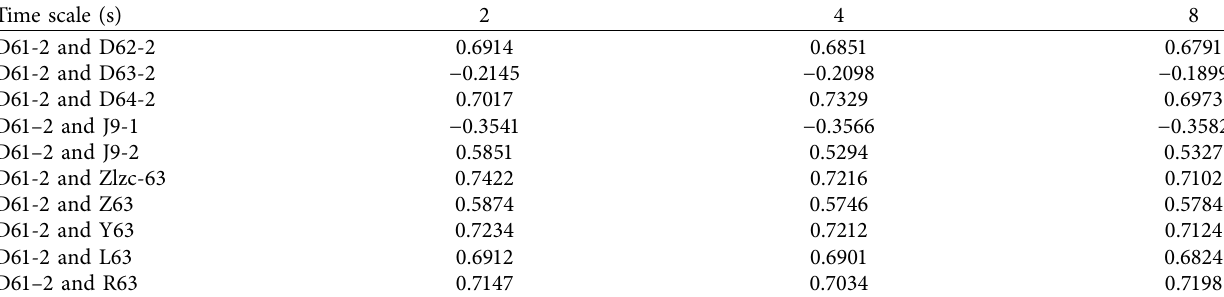
Table 3: DCCA coefficients corresponding to different scales (s).